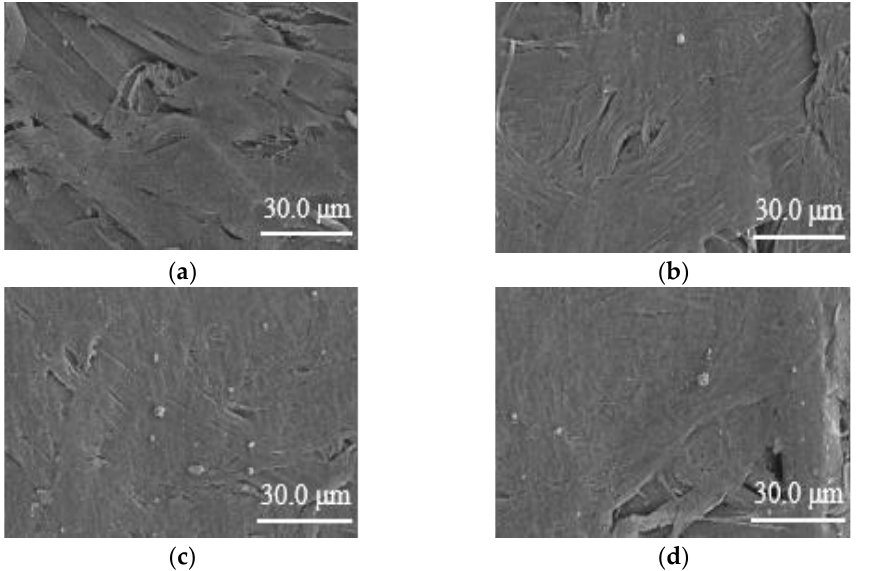
Figure 4. SEM test results (scale bar: 30 μ m) before and after the modification of aramid insulation paper ( a ) F0 Sample SEM; ( b ) F1 Sample SEM; ( c ) F2 Sample SEM; ( d ) F3 Sample SEM.